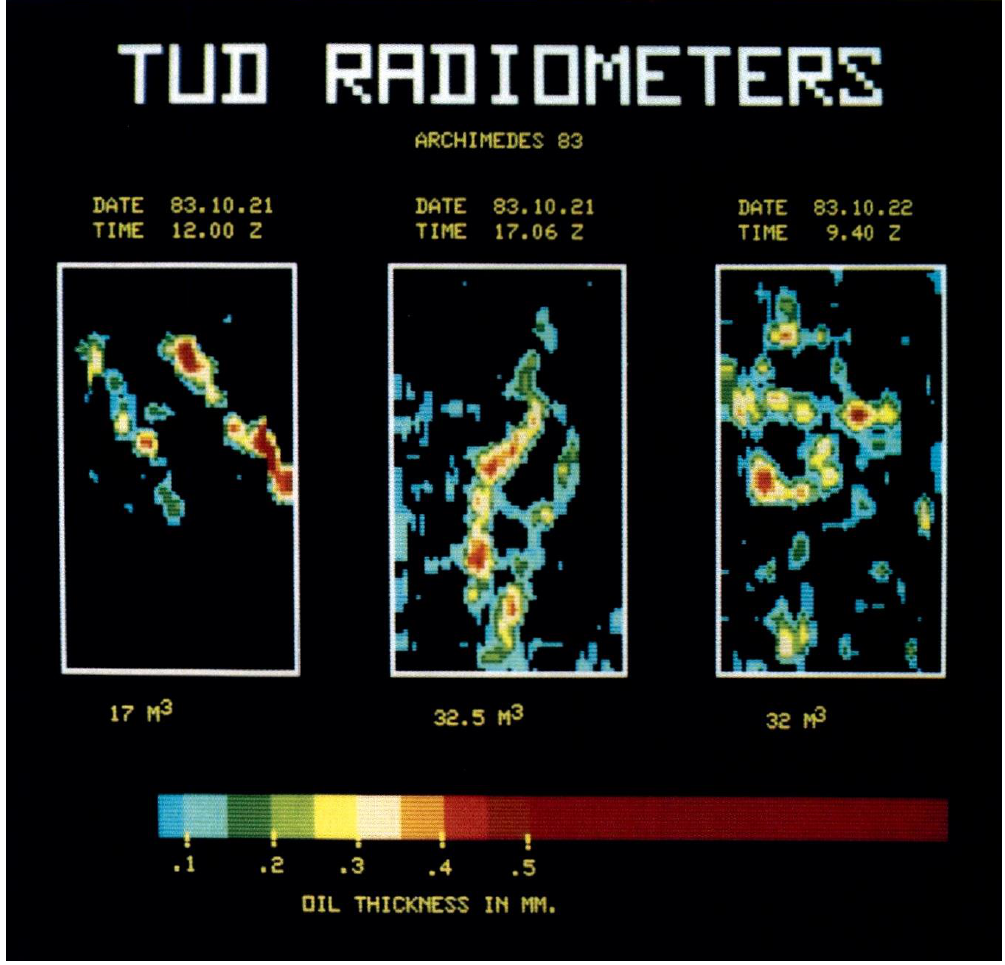
Figure 4 . An image of a slick characterized by an early microwave sensor by Skou et al. [8,9]. The integrated slick volumes are written under each figure. These images were taken using a 3-band passive microwave imager operating at 5, 17, and 34 GHz. This particular system is applicable to about 0.5 mm, after which the signal is ambiguous. Thus, this particular system would not be useful for thicker and freshly spilled oils. Therefore, it is noted that the first scan on the test slick underestimated the amount of 17 m 3 versus about 40 m 3 spilled. The scans, later on the first day and on the second day, had approximately the right amounts of oil. Because of low spatial resolution, the averaging of the surface takes place, resulting in higher estimates of oil. This is shown by the 32.5 and 32 m 3 amounts on the last part of the first day and on the second day of flights. Presumably, these amounts should have been slightly lower because of slick evaporation. It is also important to note that the sheens are not seen in microwave images. This early microwave system did not have high resolution in addition to not being well calibrated.